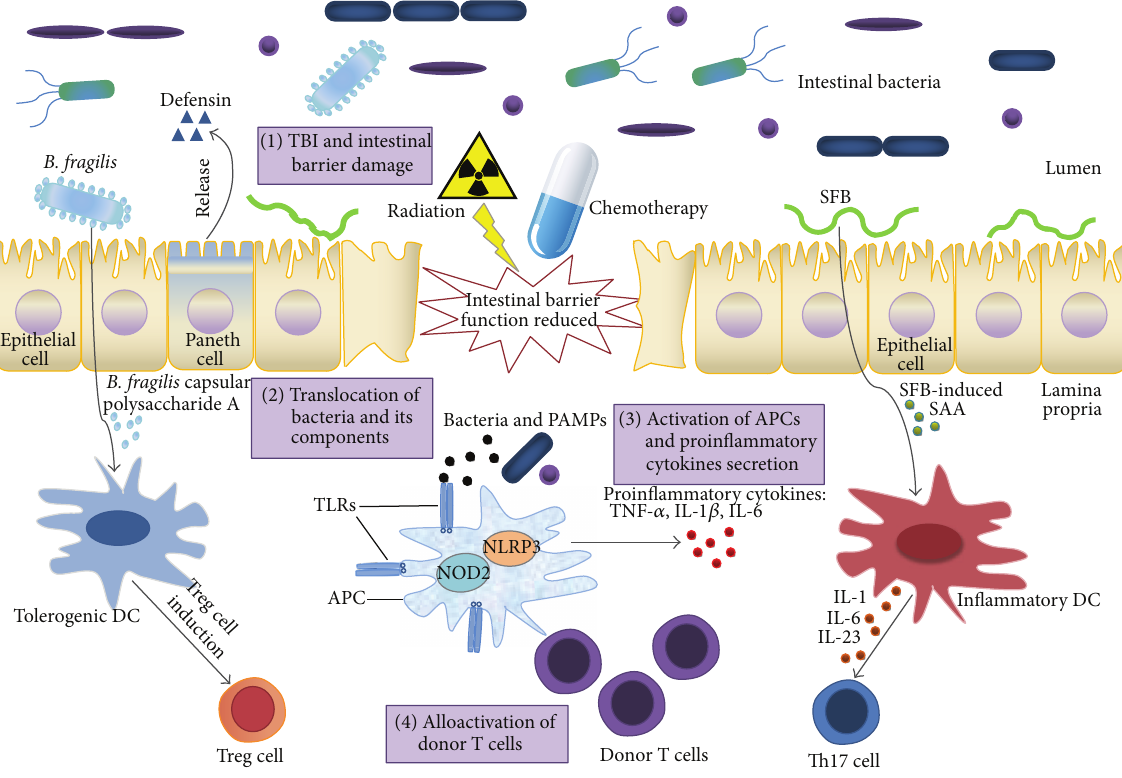
Figure 1: Schematic of the role of microbiota in graft-versus-host disease in the gut. Under normal conditions, the intestinal epithelial surface maintainsanintactbarrierfunctionthatpreventsbacterialinvasionintodeeperhosttissues.Panethcellssecreteseveralmicrobicidalproteins, including 𝛼 -defensins, which selectively kill pathogenic bacteria. Bacteroides fragilis -derived TLR capsular polysaccharide A can promote the induction of Treg cells. Segmented filamentous bacteria (SFB) induce production of serum amyloid A (SAA) in the gut, and SAA acts on dendritic cells (DCs) to promote Th17 cell differentiation. After total body irradiation (TBI) and chemotherapy as part of the conditioning regimen, theintegrity oftheintestinal surfaceis decreased. Intestinalbacteria and theircomponents (pathogen-associated molecular patterns, PAMPs) translocate to the lamina propria and are recognized by Toll-like receptors (TLRs) in host antigen-presenting cells (APCs). Activated APCs secrete proinflammatory cytokines and prime donor T cells, which aggravate acute